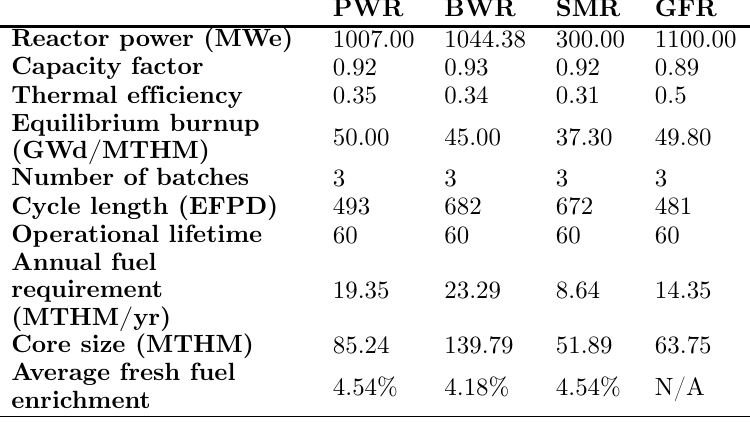
Table 1. Design and operational specifications for all reactors modeled in the